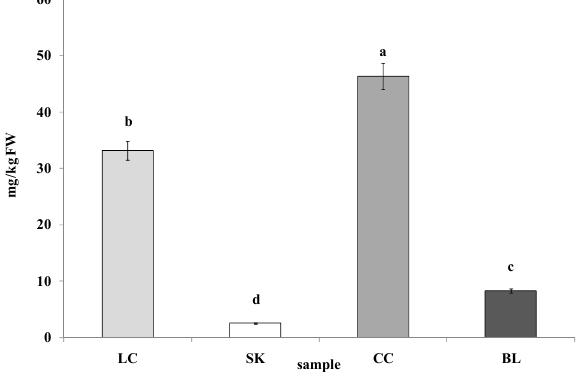
Figure 3. Betalains content in leaves of red chard (LC), white beetroot (SK), red beetroot (CC), and white chard (BL). Results are presented as the mean ± SD; the values designated by the different small letters (a, b, c, d) are significantly different ( α = 0.05).